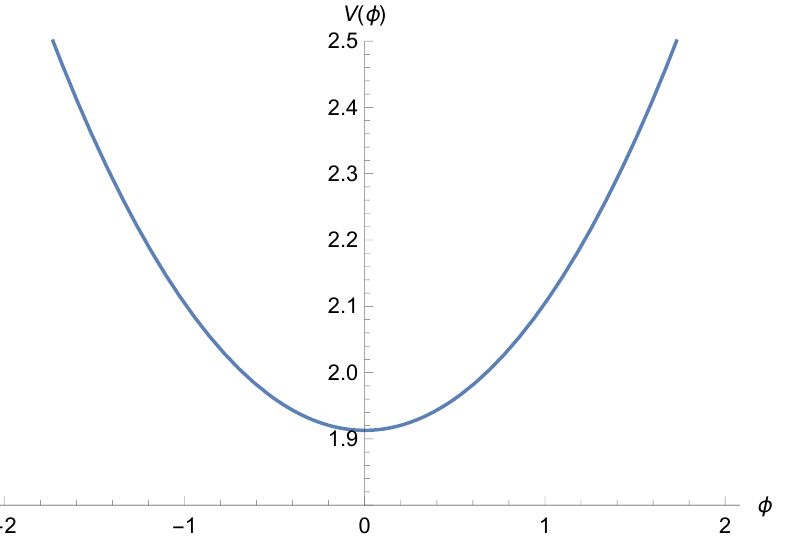
Figure 15. Bouncing trajectory of the Universe volume V = ( v 1 v 2 v 3 ) 1/3 as function of φ in the semiclassical polymer